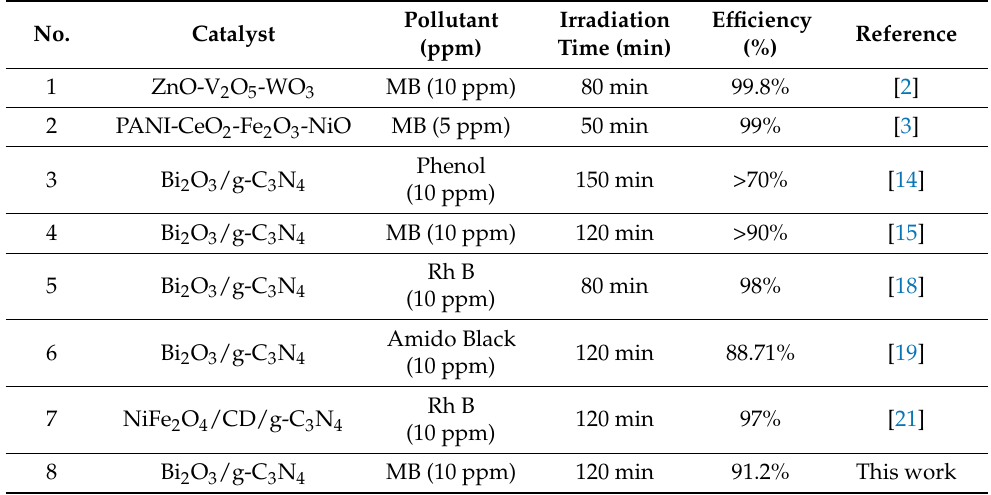
Table 1. Comparison